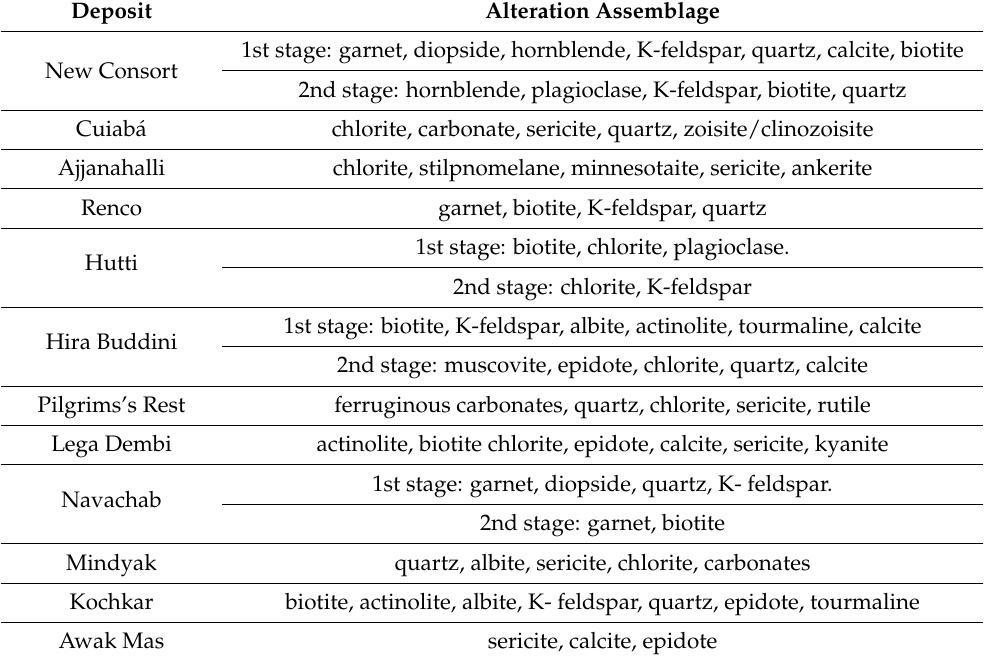
Table 5. Hydrothermal alteration